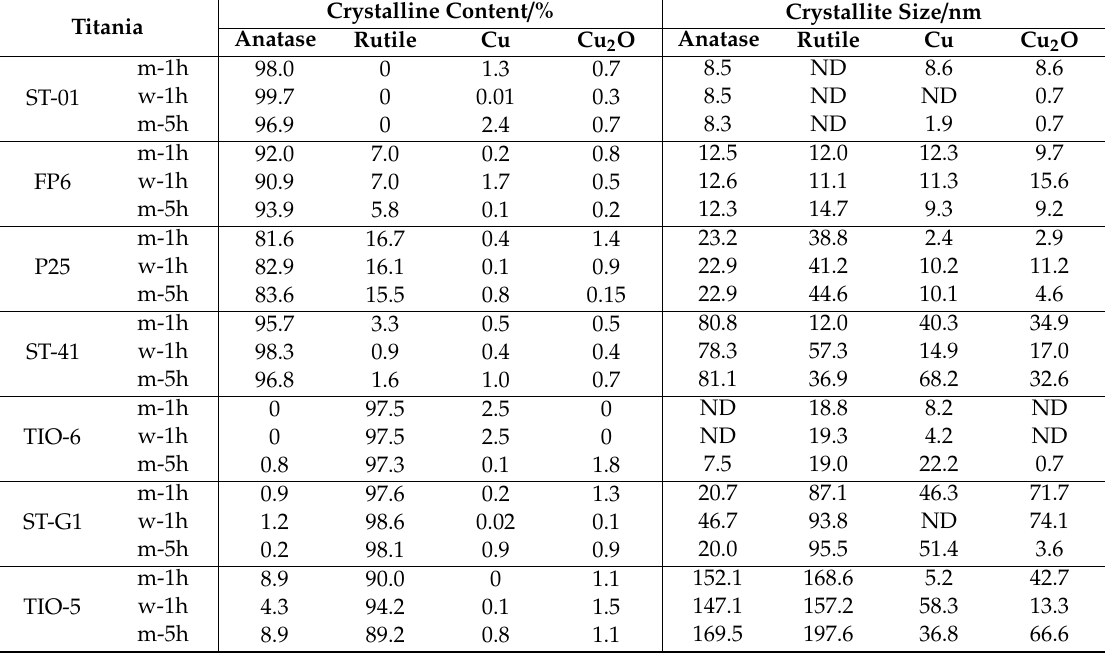
Table 2. The crystalline properties of Cu-modified titania by XRD